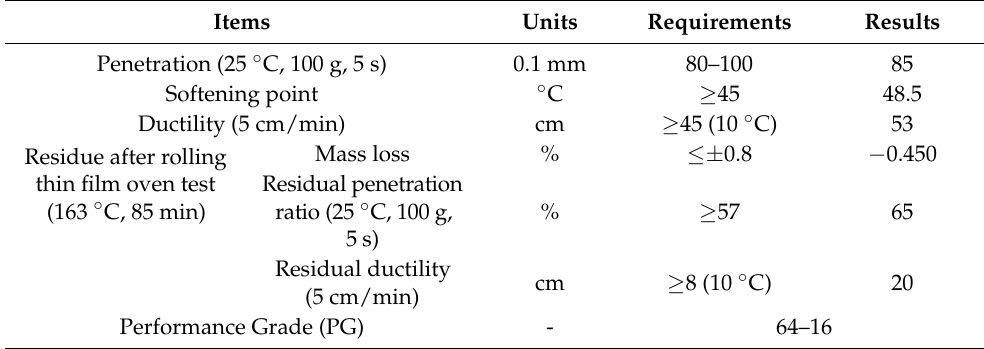
Table 1. Physical properties of the base asphalt binder sample. Items Units